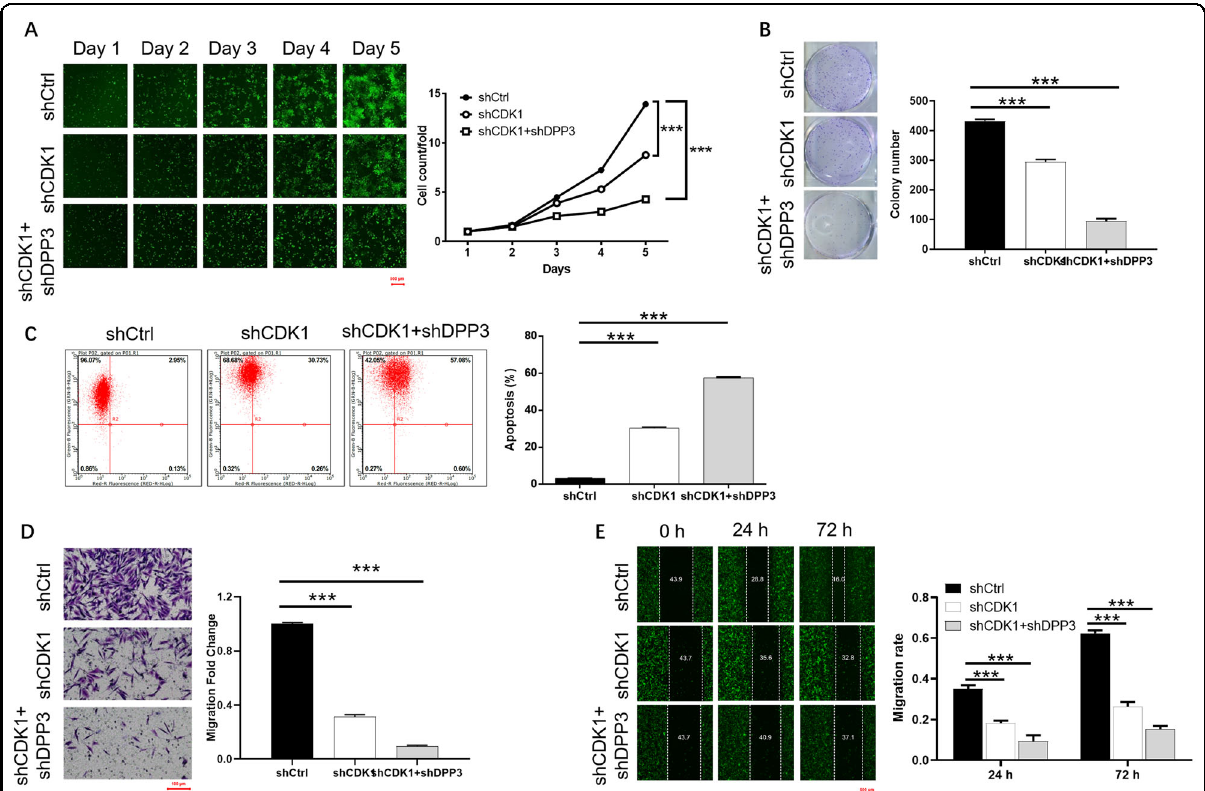
Fig. 5 Knockdown of DPP3 deepens the effects on CRC cells by CDK1 knockdown. Cell models were subjected to the detection of cell proliferation by Celigo cell counting assay ( A ), colony formation ( B ), cell apoptosis ( C ). Cell migration was detected by Transwell assay ( D ) and wound-healing assay ( E ). The representative images were selected from at least three independent experiments. Data were shown as mean ± SD. * P < 0.05, ** P < 0.01, *** P <